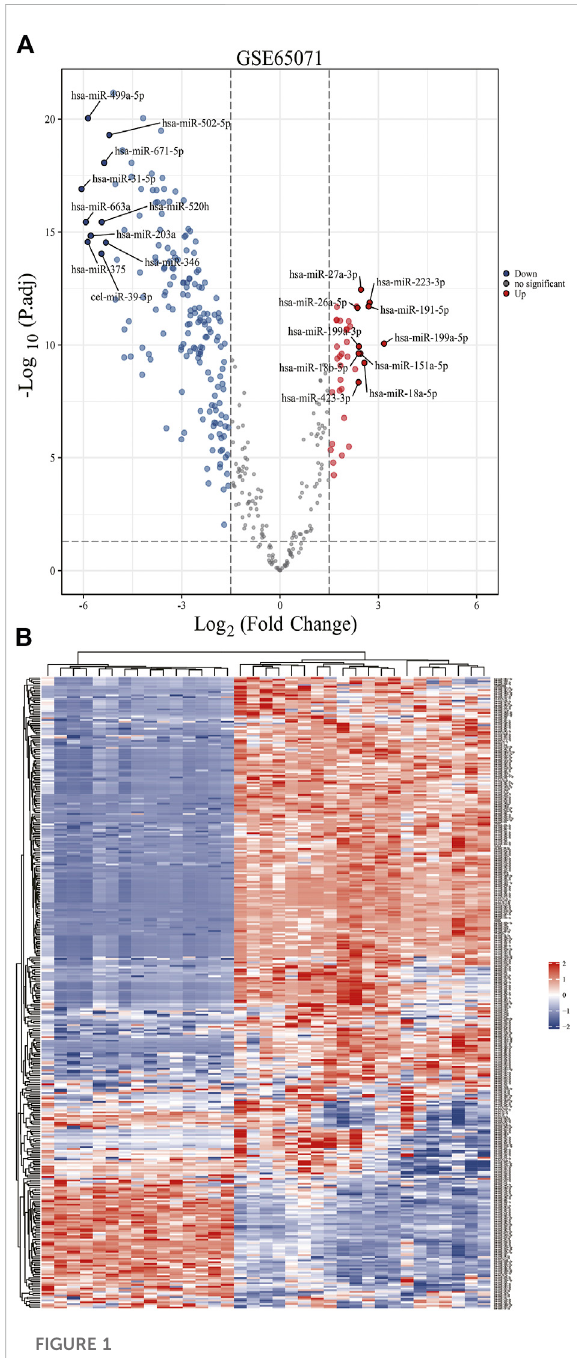
FIGURE 1 Identi fi cation of DE-miRNAs in OS and control samples. (A) The volcano plots and Heatmaps showing all the expressed genes from GSE65071. (B) The Heat maps showing all the expressed genes from GSE65071. Blue represents downregulated genes, and red represents upregulated genes. Each column represents a probe, and each row represents a gene. DE-miRNAs: differentially expressed